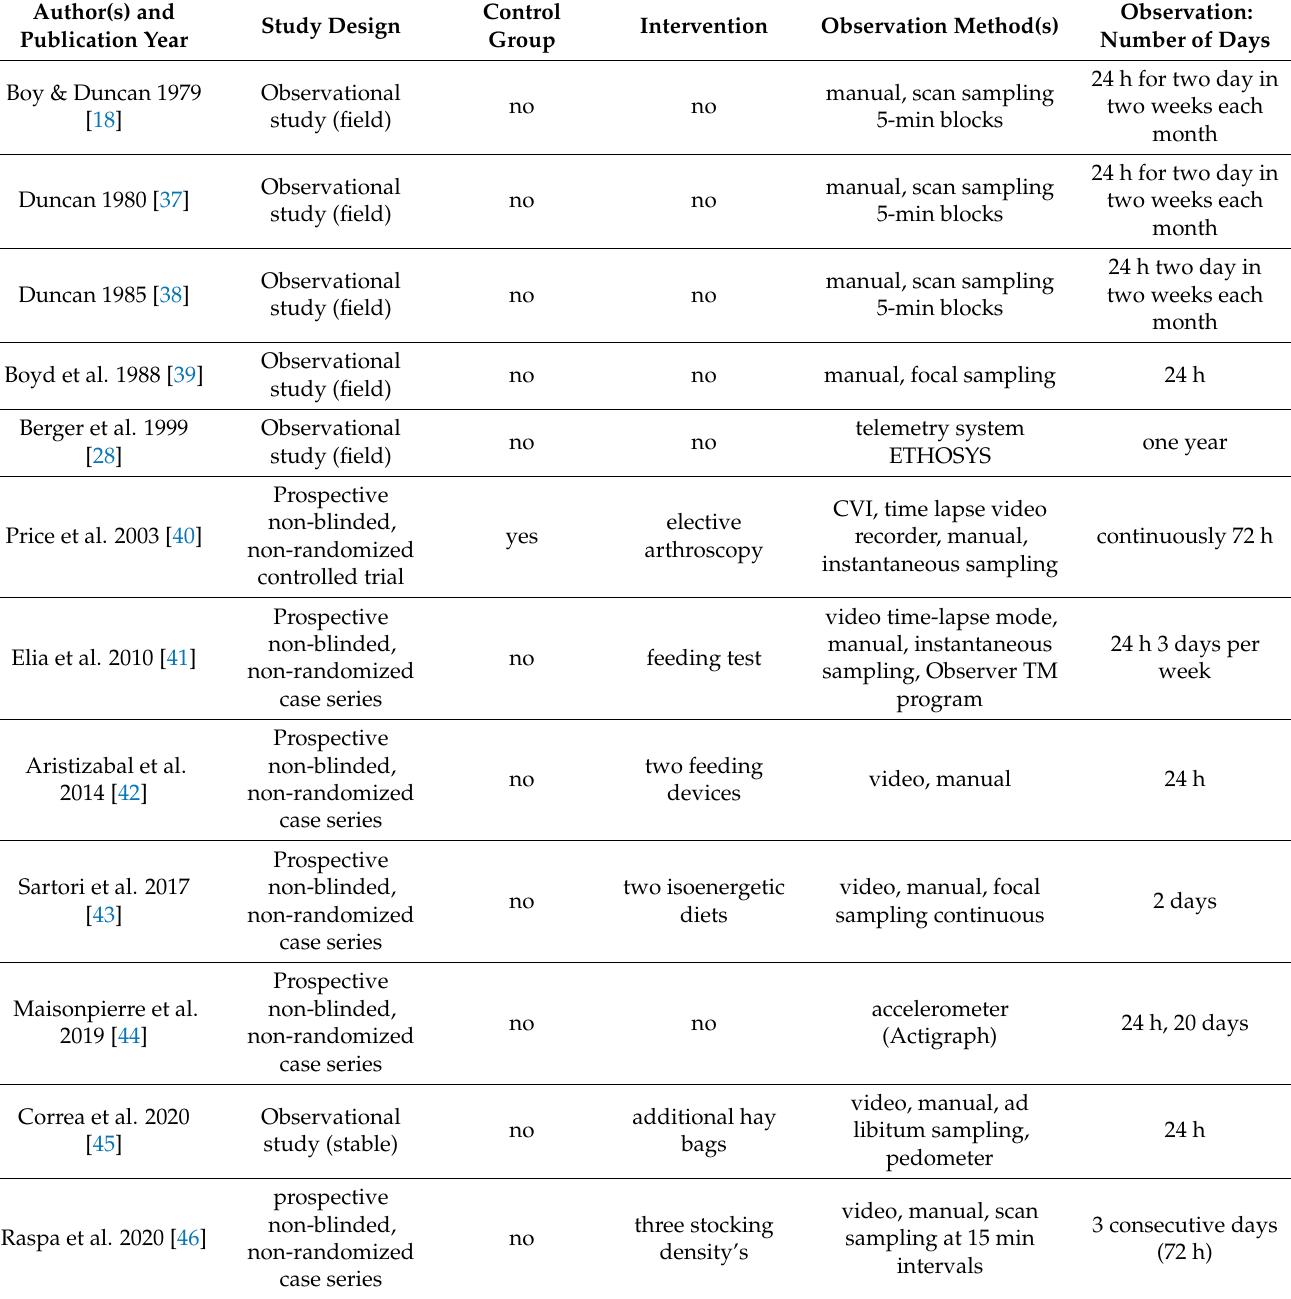
Table 1. List of the included articles, their study design, observation method, the observation method(s), and the numbers of observation